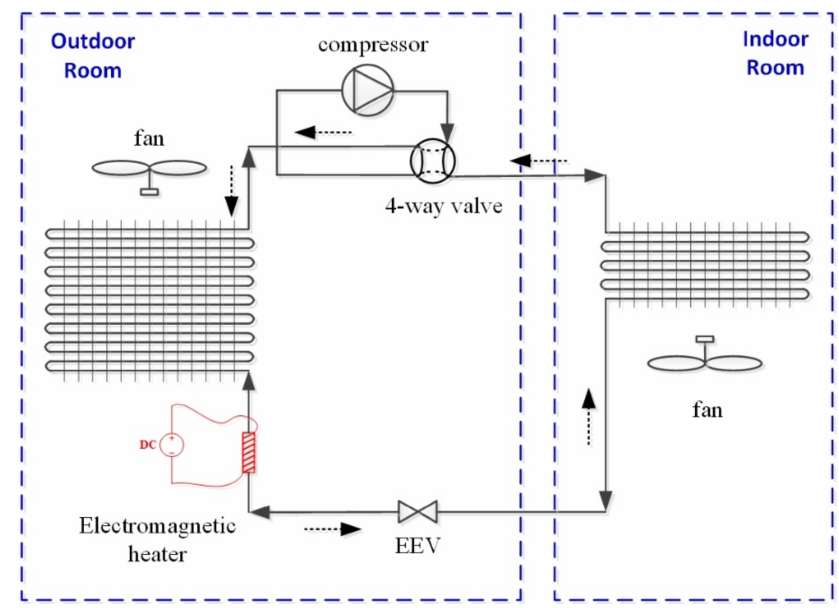
Figure 1. Schematic diagram of the tested ASHP